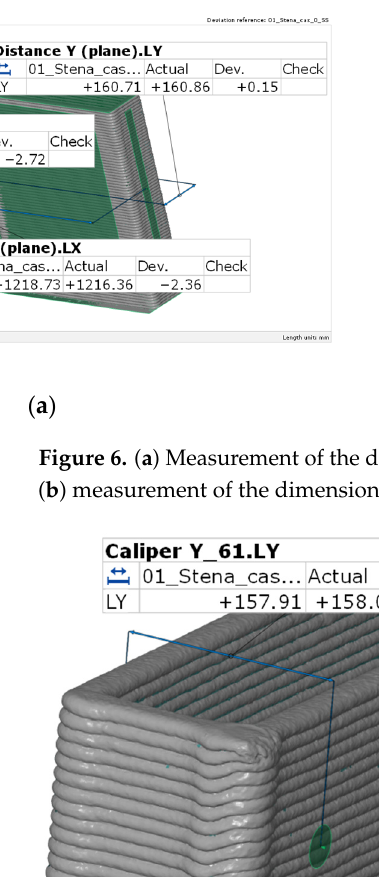
Figure 7. Local distance measurement with the “Caliper” function.